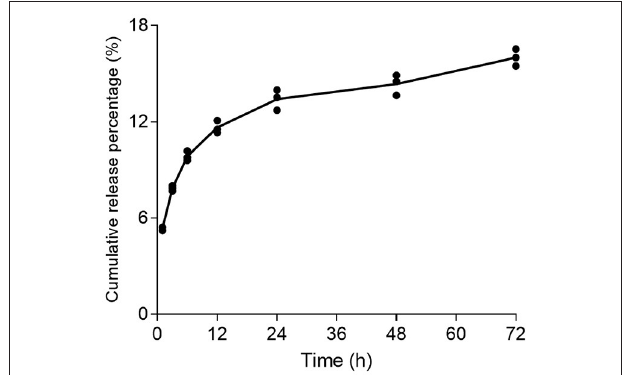
FIGURE 6 | Kinetics of 17-DMAG release from NP2-17-DMAG. NP2-17-DMAG were lyophilized and incubated in complete DMEM medium under rotary agitation at 37 ◦ C. After 1, 3, 6, 12, 24, 48 or 72h, samples were centrifuged, the supernatant was collected, and the medium was replaced. The release of 17-DMAG was quantified in supernatants using HPLC. Mean, n =